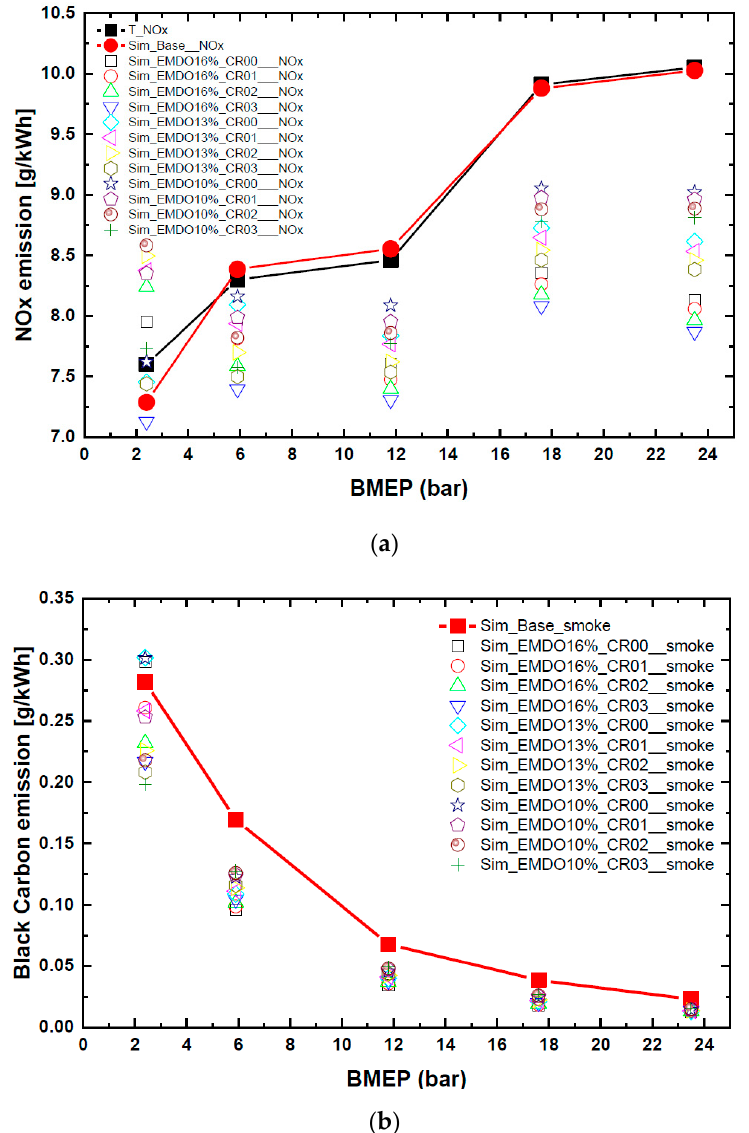
Figure 15. Emission characteristics of nitrogen oxide (NOx) and black carbon versus the turbocharger compression ratio and three types of emulsified marine diesel oil; ( a ) NOx emission, ( b ) black carbon emission.